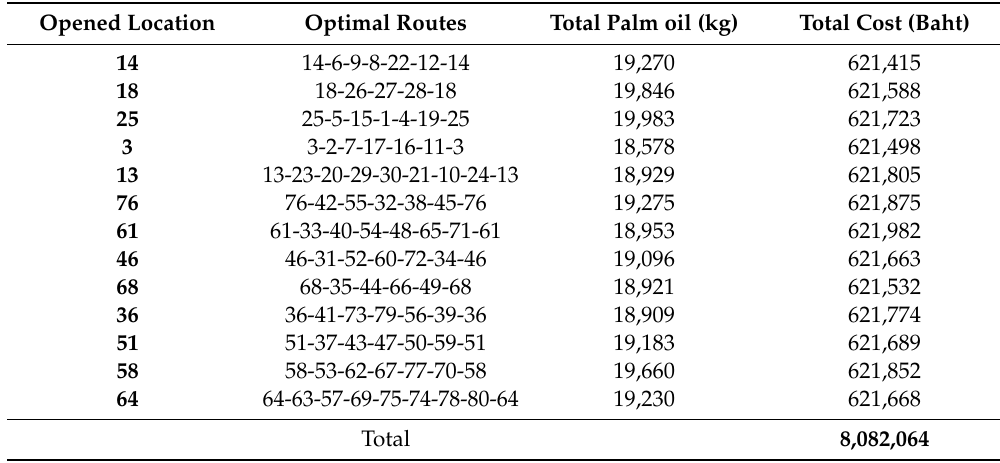
Table 9. Case study